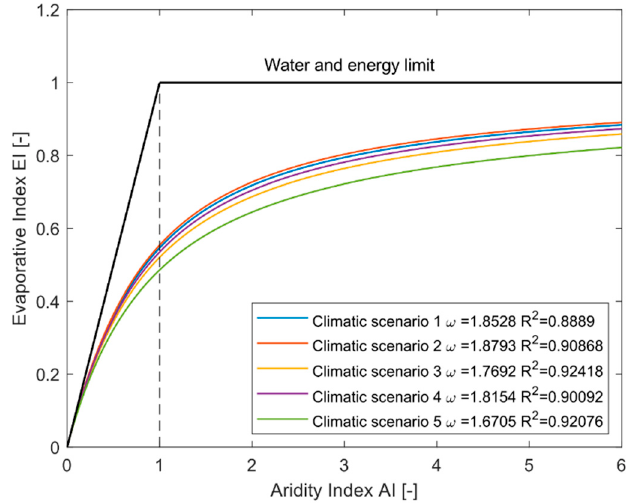
Figure 6. The five associated Fu’s equations related to the test-watershed in the five different climatic scenarios. In the inset, the optimized ω and the R 2 are reported referring to the five curves.